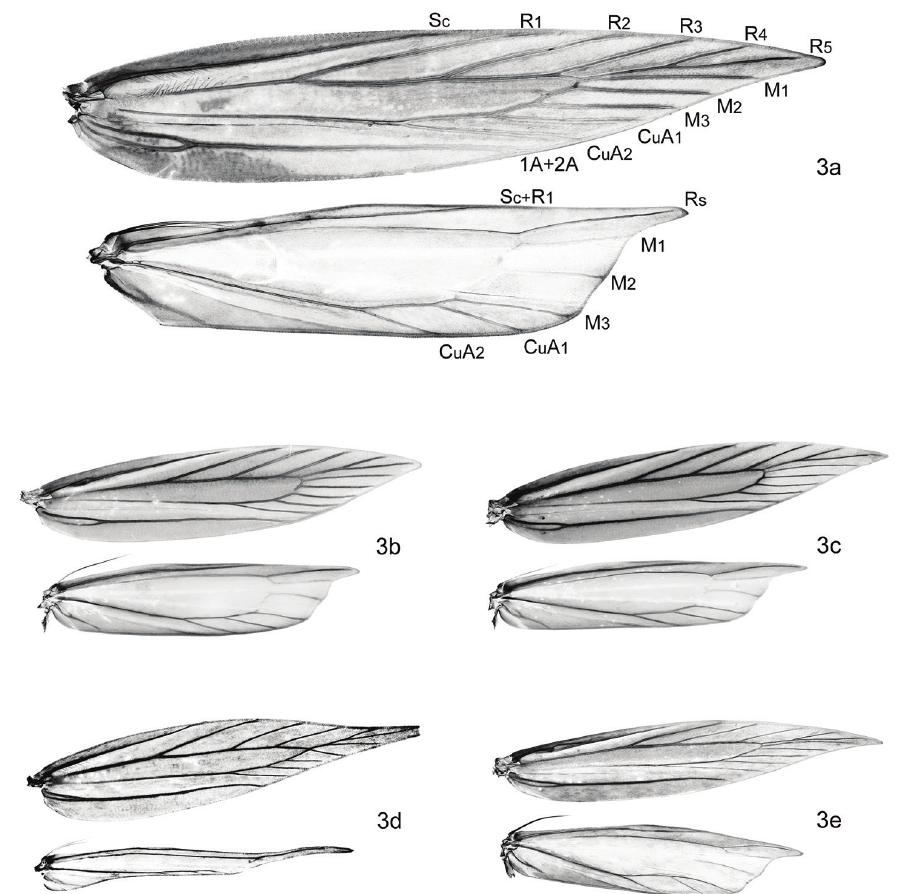
Figure 3. Wing venation of Megacraspedus . a M. lagopellus Herrich-Schäffer, 1860 – male, Armenia, (NMPC), forewing 8.5 mm b M. peyerimhoffi Le Cerf, 1925 – male, Spain (NMPC), forewing 9 mm c M. peyerim- hoffi Le Cerf, 1925 – female, Spain (NMPC), forewing 10 mm d M. binotella (Duponchel, 1843) – female, Slovakia (NMPC), forewing 5.5 mm e M. fallax (Mann, 1867) – male, Russia (NMPC), forewing 8.5